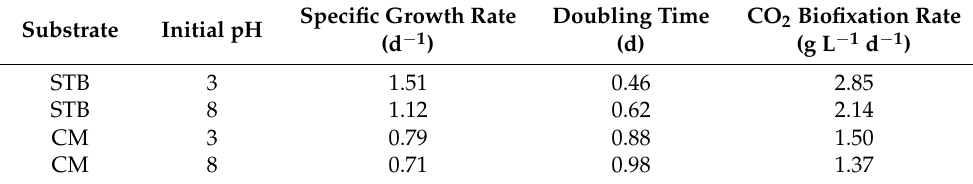
Figure 3. ( a ) Biomass production, ( b ) COD consumption, and ( c ) T-N consumption using STB and CM medium at an initial pH 3. Sample analyses were performed in duplicate, and the data were represented as average ± standard error ( n = 4). Table 3. Specific growth rate, doubling time, and CO 2 biofixation rate using STB and CM using different initial pH conditions.